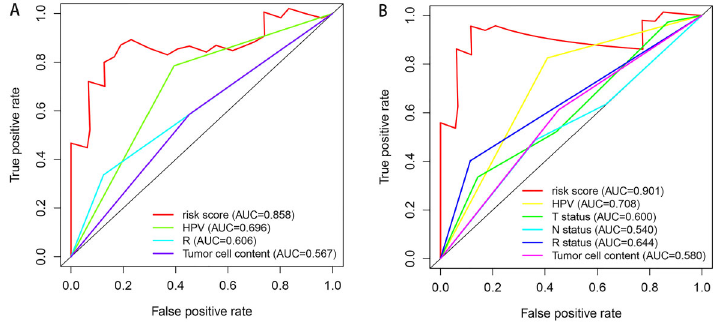
Figure 7. Prognostic performance of the risk factors models. ROC curves demonstrated the predictive abilities for ( A ) disease-speci fi c survival (DSS) and ( B ) progression-free survival (PFS). The area under the curve (AUC) ranged from 0.5 to 1.0.